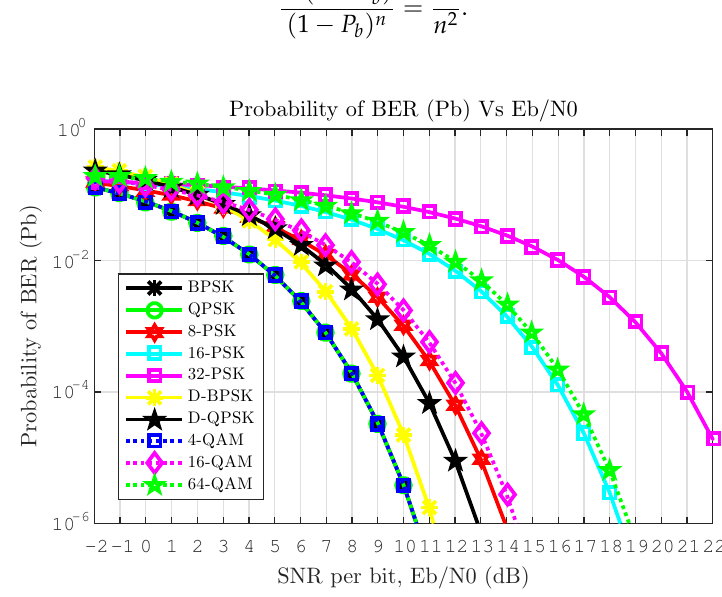
Figure 3. BER versus SNR per bit ( E b / N 0 ) for digital modulation schemes.